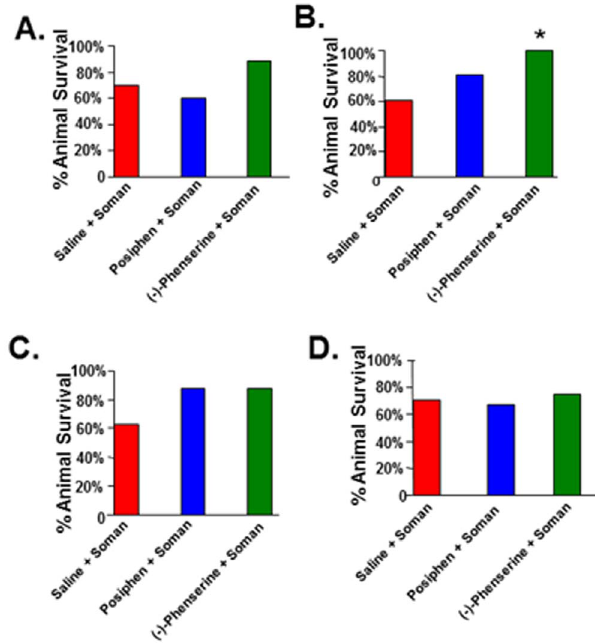
Figure 1. Administration of ( 2 )-phenserine prior to but not after soman protects against soman-induced mortality. Rats were administered ( 2 )-phenserine, posiphen or saline 4 hr (A), or 30 min (B) prior to or 5 min (C) or 30 min (D) after soman. In the 4 hr pretreatment groups of animals, 12 rats died in the posiphen group and 11 rats died in the control group. There were no deaths in the ( 2 )- phenserine group. In the 30 min pretreatment groups of animals, 2 animals died in the ( 2 )-phenserine group. The bar represents the percent of surviving rats 24 hr after soman exposure calculated as: number of surviving rats 24 hr after soman/total number of rats 6 100. n=17–20. *p , 0.026 vs saline/soman by Fisher exact test.